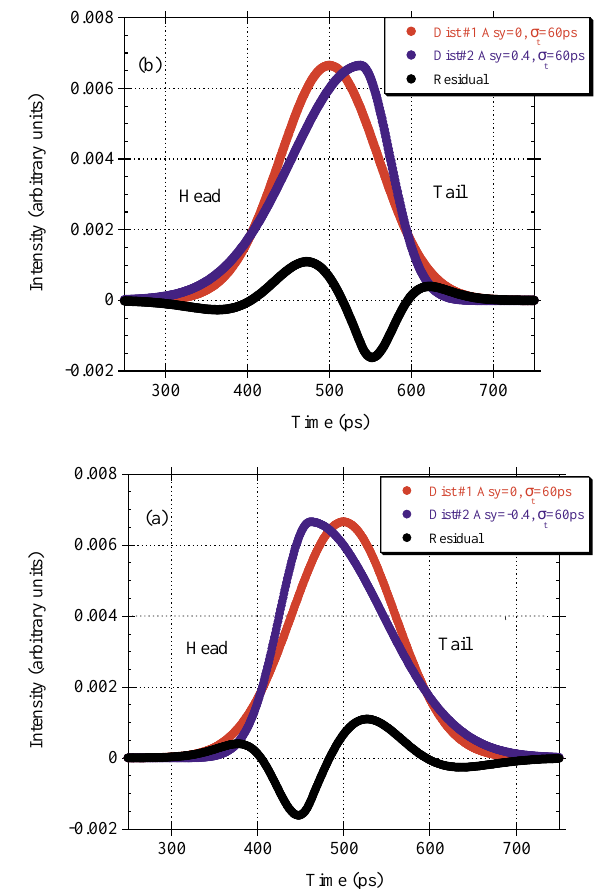
FIG. 19. (Color) Two asymmetric Gaussian distributions with the same bunch length and asymmetry factors of (a) A 1 (cid:1) 0 and A 2 (cid:1) 2 0.4 , and (b) A 1 (cid:1) 0 and A 2 (cid:1) 0.4 . The residual between the two distributions is also